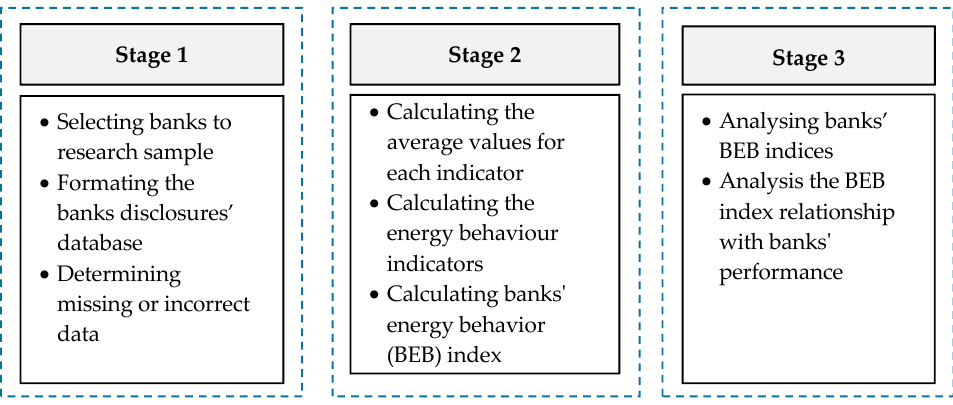
Figure 1. The scheme of the BEB index stage calculation. Source: Own contribution of the authors based on [42].